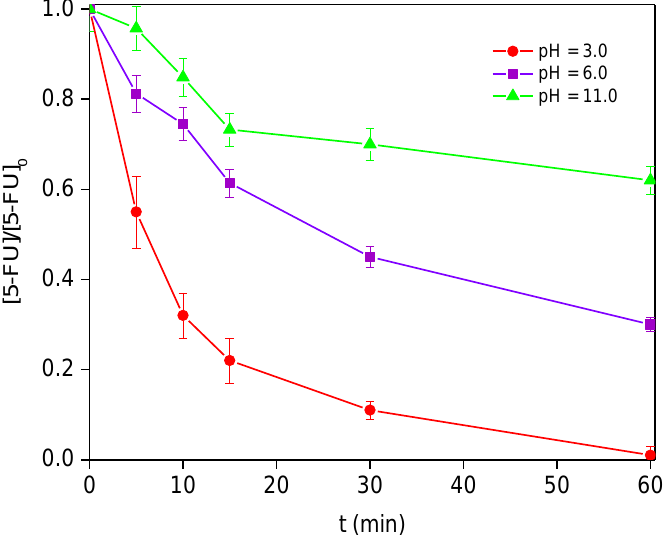
Figure 5. 5-FU degradation at various pH values under simulated solar radiation (58 mM of H 2 O 2 and 100 mg L − 1 of Fe 3 O 4